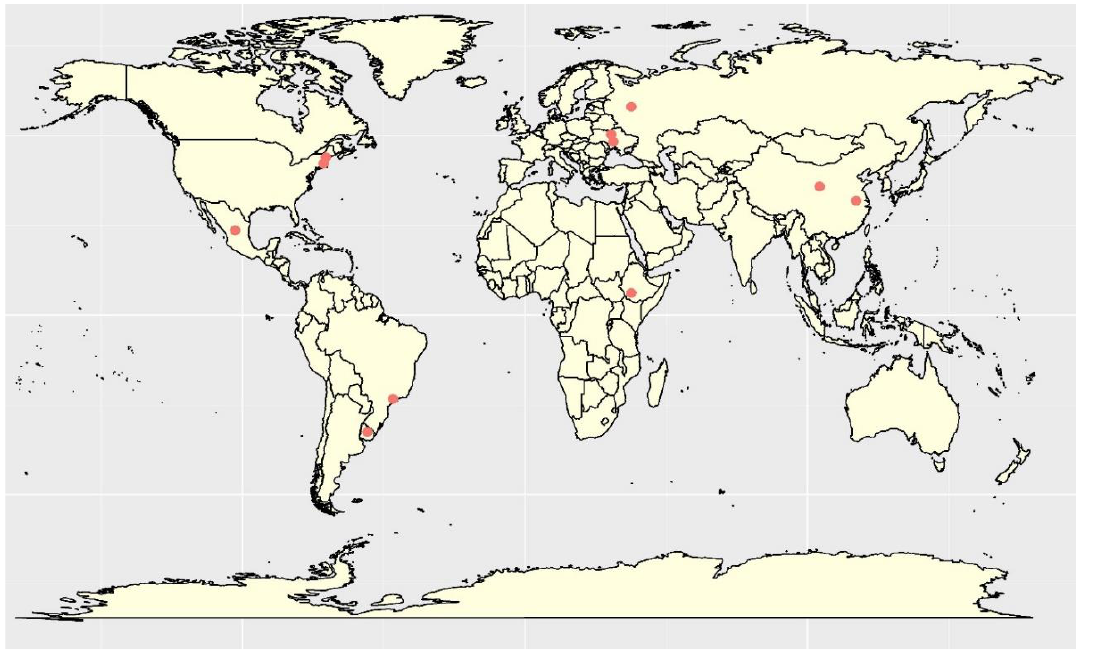
Figure 2. Map showing the experts who participated to respond to the questionnaire from around the globe.